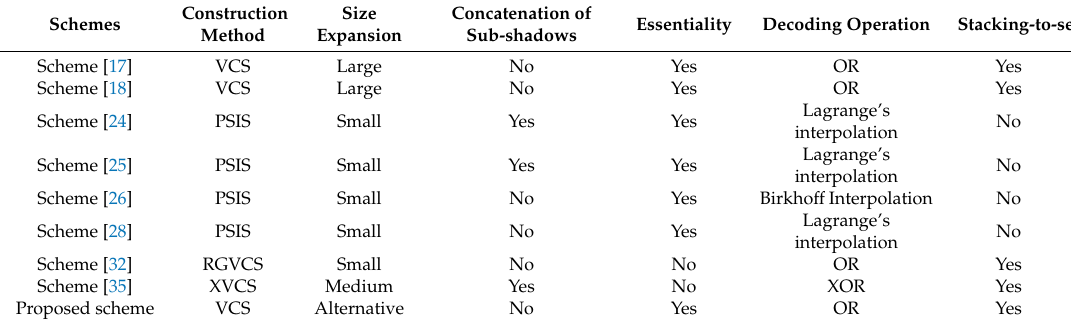
Table 9. The comparison of functionality among the literature schemes and proposed